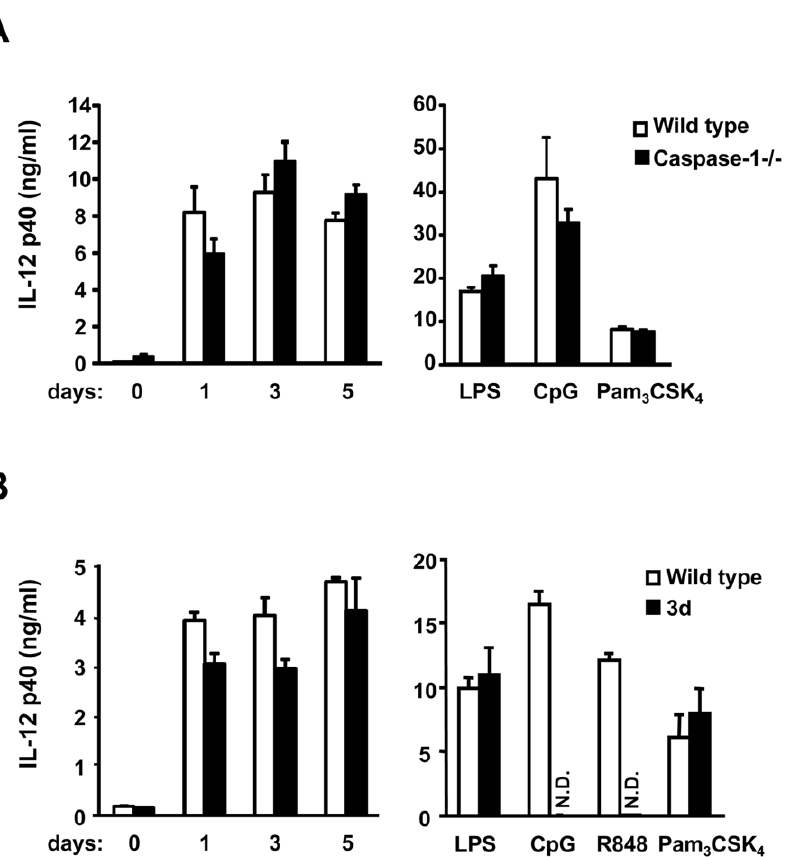
Figure 5. Recognition of E.muris in DCs is IL-1/IL-18 signaling and UNC93B1-independent. Bone marrow-derived DCs from wild-type, caspase-1-deficient (A), or 3d (B) mice were infected with E. muris for the indicated time period, and IL-12 p40 production from infected cells was assessed by ELISA. LPS (10 ng/ml), CpG (1 m M), R-848 (1 m M) and Pam 3 CSK 4 (1 m g/ml) stimulations were used as controls. Error bars represent the SD of triplicate samples. Data are representative of three independent experiments in A and B. N.D., not detected.